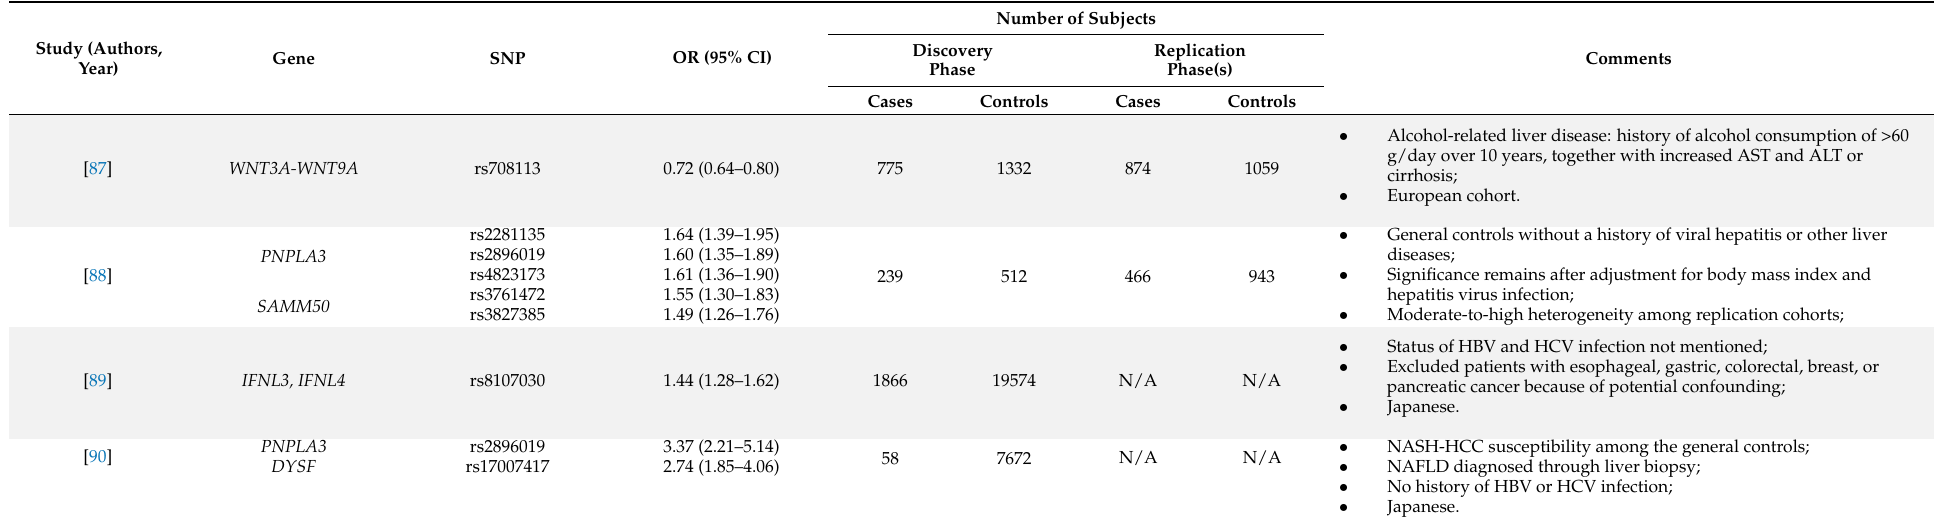
Table 4. GWASs of the Susceptibility of HCC Unrelated to Viral